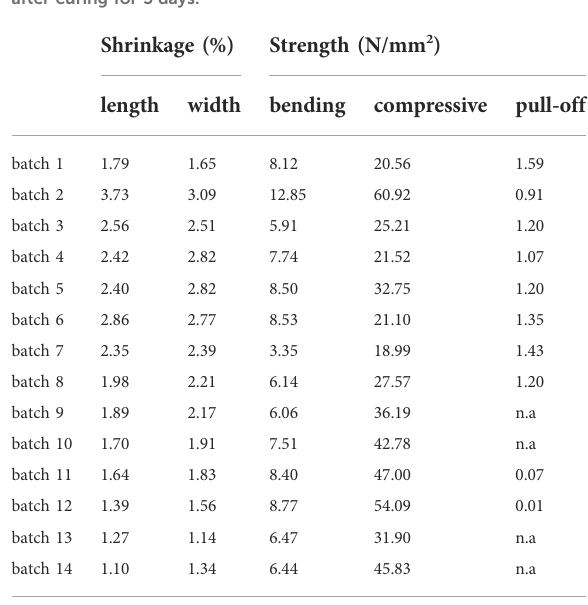
TABLE 3 Results of the preliminary experiments performed on samples representing the respective batches to determine their shrinkage and bending, compressive and pull-off strengths of test {A} after curing for 3 days.